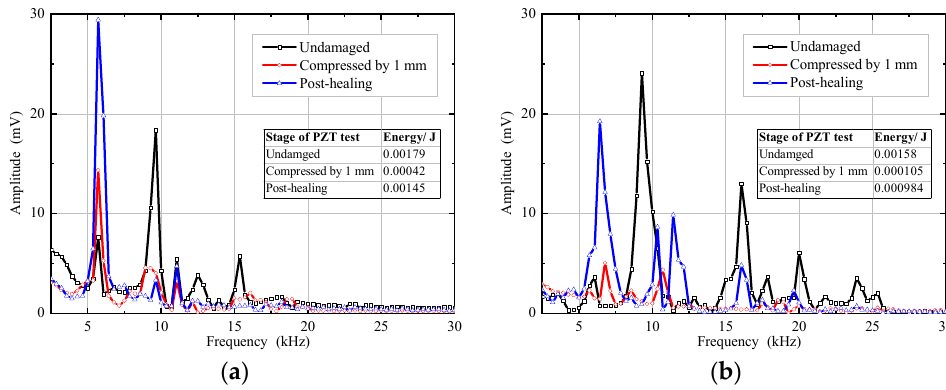
Figure 13. Frequency spectrum for microcapsule-based CCS specimens: ( a ) in freshwater; ( b ) in sea- water.